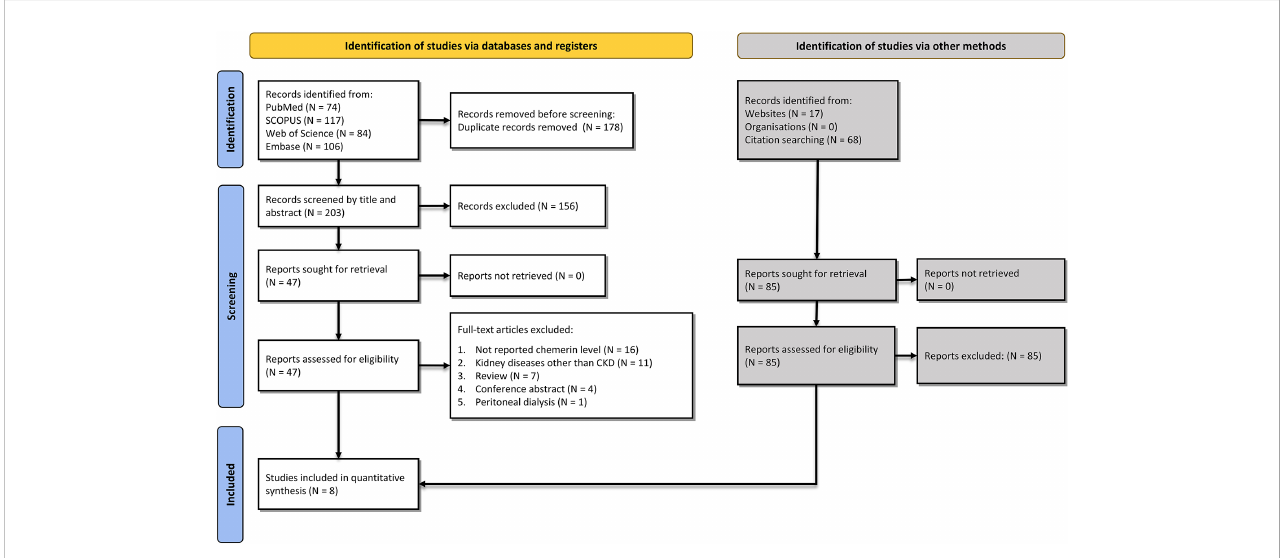
FIGURE 1 Flow diagram summarizing the selection of eligible studies based on the PRISMA